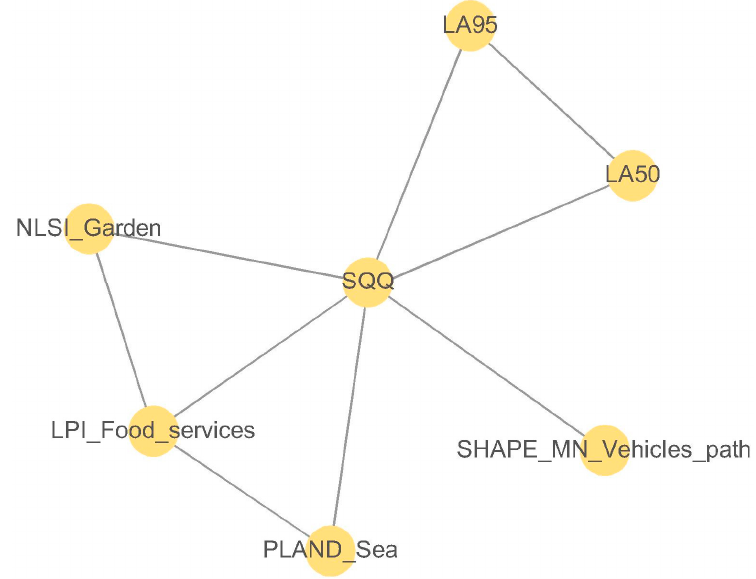
Figure 8. Inferred mRMR network topology of the soundscape quality (SQQ) for the road traffic areas. The variables selected were the spatial metric “normalized landscape shape” calculated for the land use “garden” (NLSI_Garden), spatial metric “large patch index” calculated for the land use “food service” (LPI_Food), spatial metric “percentage of land use” calculated for the land use “sea” (PLAND_Sea), spatial metric shape calculated for the land use “vehicles path” (SHAPE_MN_Vehicles_Path), A-weighted sound pressure level exceeded 50% of time (LA50) and A-weighted sound pressure level exceeded 95% of time (LA95).